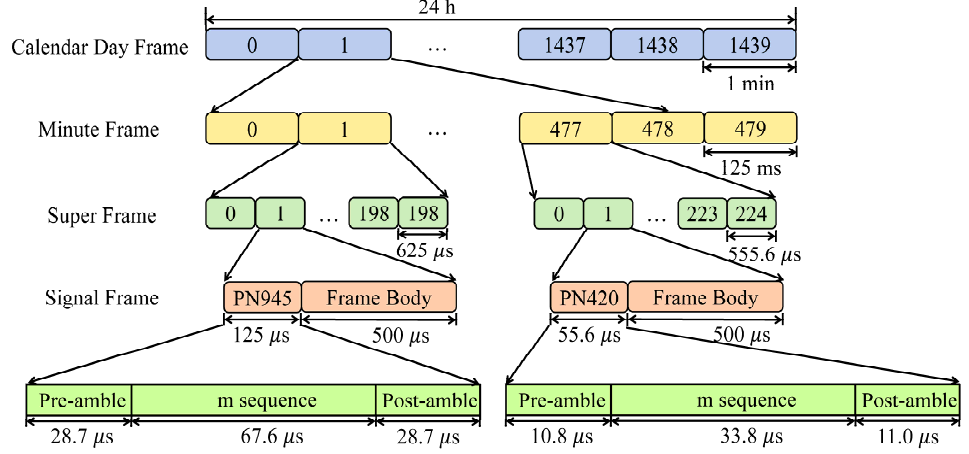
Figure 1. The frame and PN sequence structure of DTMB signal in multi-carrier mode.